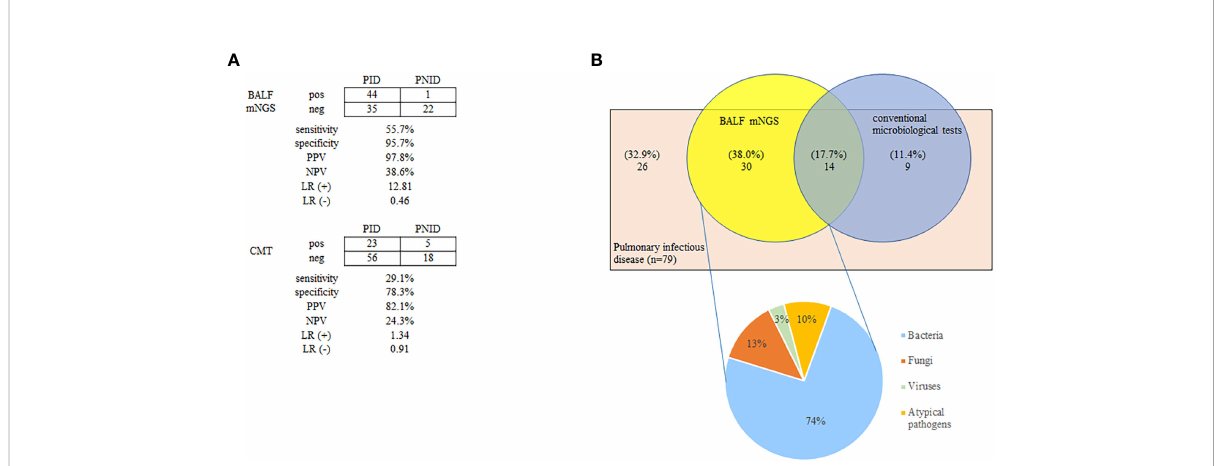
FIGURE 1 Positivity rates of BALF mNGS and CMTs for pulmonary infectious and non-infectious diseases (A) , and diagnosis assisted by BALF mNGS for PID without identi fi able etiology by CMTs (B) . The positive predictive value of BALF mNGS for the diagnosis of infectious disease was 97.8%, and the negative predictive value was 38.6%. BALF mNGS increased the sensitivity rate by approximately 27% in comparison with CMTs (55.7% vs. 29.1%; p < 0.01) (A) . Thirty patients (38.0%) were BALF mNGS-positive despite comprehensive CMTs being negative. Bacteria constituted the highest proportion of pathogens (74%) (B) . BALF, bronchoalveolar lavage fl uid; CMT, conventional microbiological test; LR(+), positive likelihood ratio; LR(-), negative likelihood ratio; mNGS, metagenomic next-generation sequencing; NPV, negative predictive value; PPV, positive predictive value; PID, pulmonary infectious disease; PNID, pulmonary non-infectious disease; ROC, receiver operating